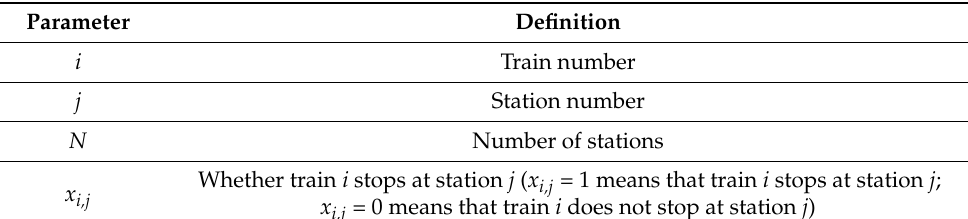
Table 1. Definition of model